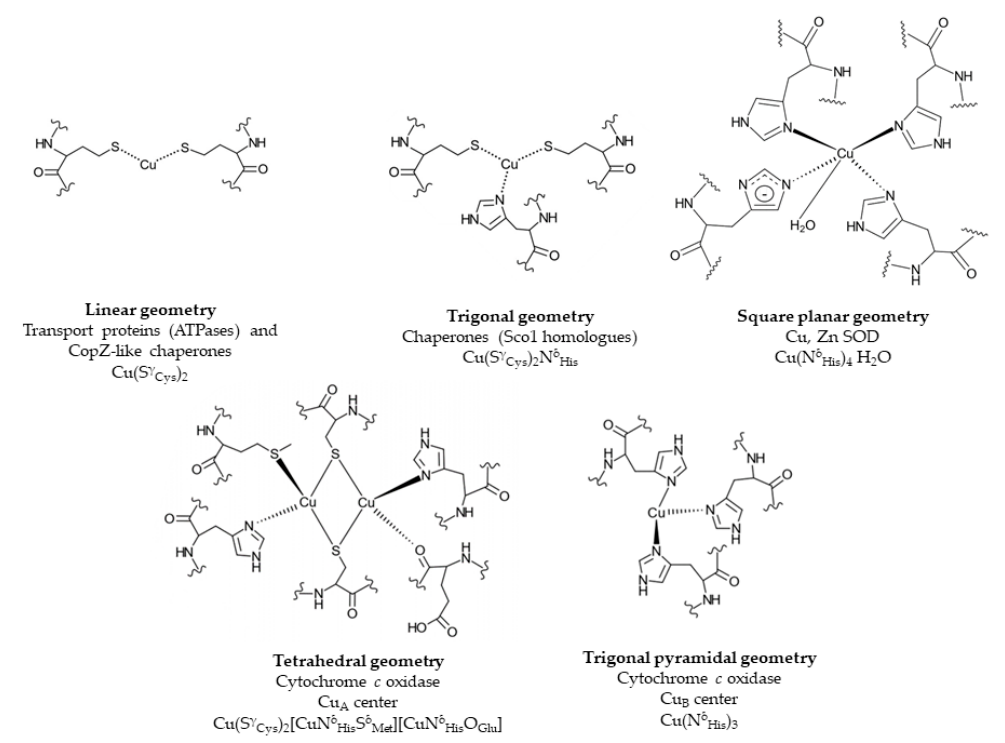
Figure 2. Examples of Cu binding sites in Cu trafficking proteins and cuproenzymes. Cu-transporting P 1B -type ATPases and Cu chaperones, such as CopZ, contain a linear CxxC Cu binding motif, while in Cu chaperones, e.g., Sco1, a distal histidine residue provides an additional ligand, resulting in a trigonal planar geometry. In the cuproenzyme Cu, Zn superoxide dismutase (SOD), four histidine residues ligate Cu in a square planar geometry. The Cu A center of cytochrome oxidase displays a tetrahedral geometry with two cysteines, two histidines, one glutamate and one methionine residue. In the CuB center, Cu is ligated by three histidine residues. Chemical structures were generated using ChemDoodle. The figure was adapted and modified from [54] .